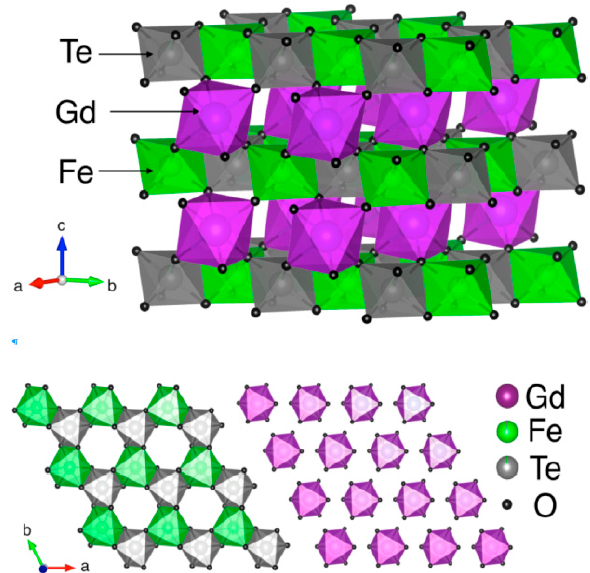
Figure 2. Upper panel: Polyhedral presentation of the crystal structure of GdFeTeO 6 , Violet, green, grey and black spheres are Gd, Fe, Te and O ions, respectively. Lower panel: magnetoactive layer of Fe and Te ions, and Gd layer. A three-dimensional visualization system VESTA [20] for electronic and structural analysis has been used for the presentation of crystal structure.